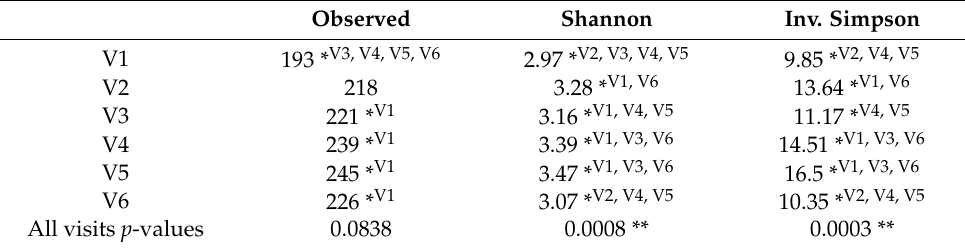
Table 3. Comparison of the alpha-diversity indices of the microbiota samples from the six visits.